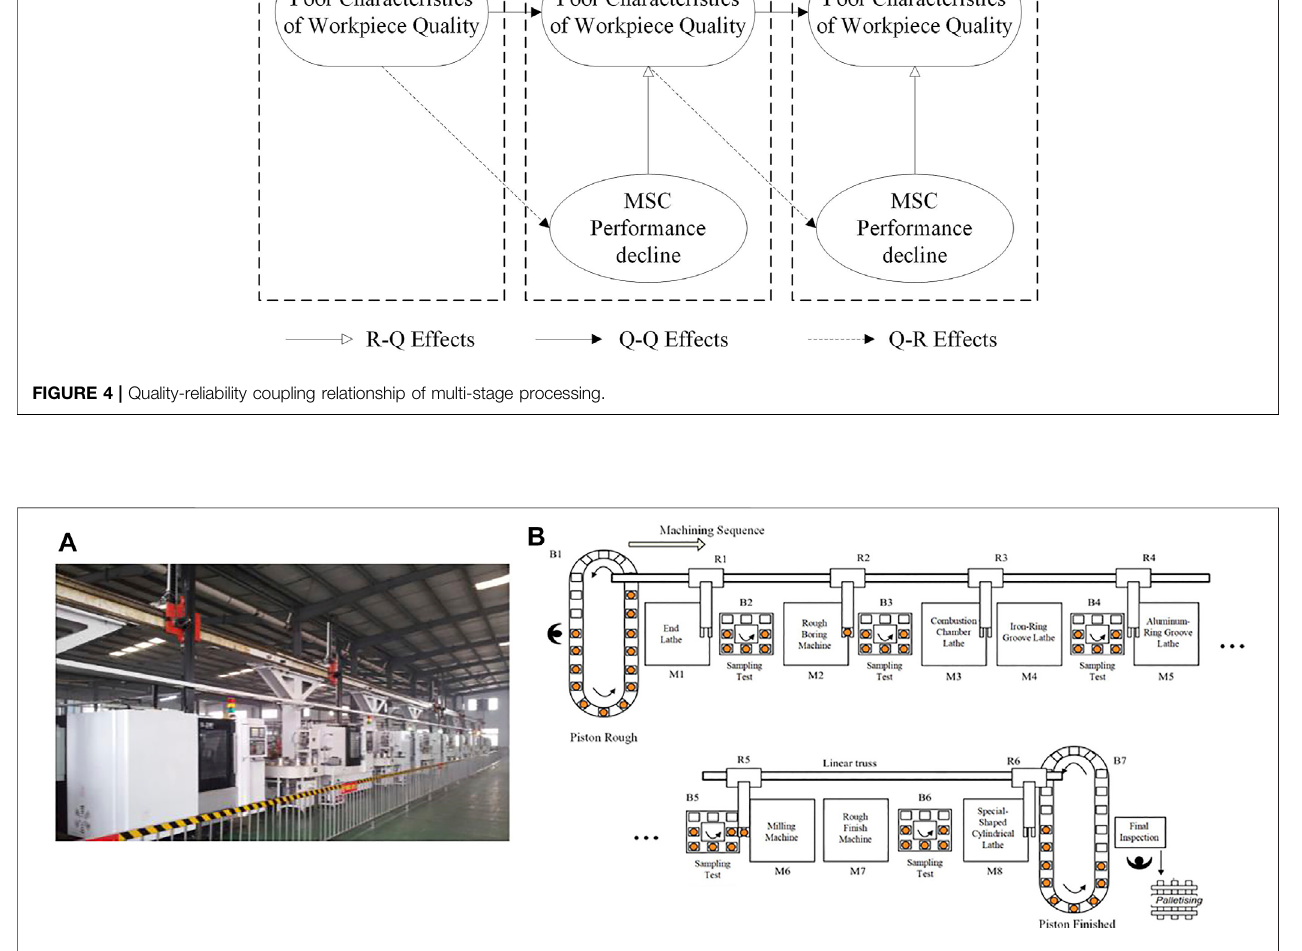
FIGURE 5 | Piston production line. (A) Production line workshop (B) Machining